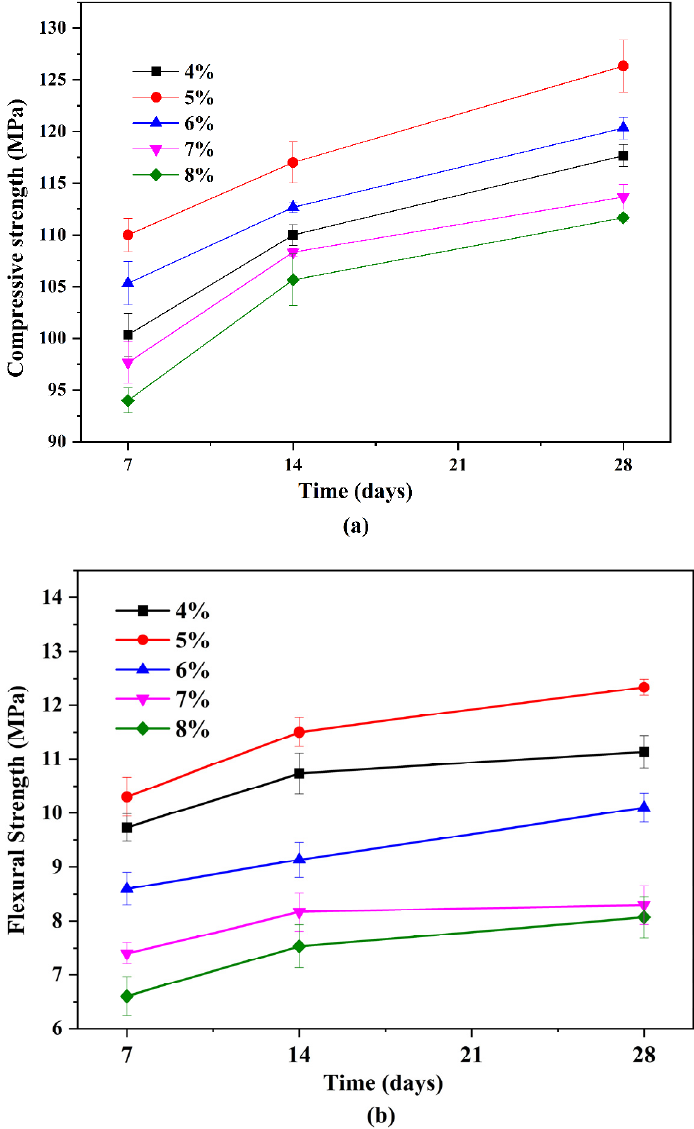
Figure 11. Relationship between the alkali content and ( a ) compressive strength and ( b ) flexural